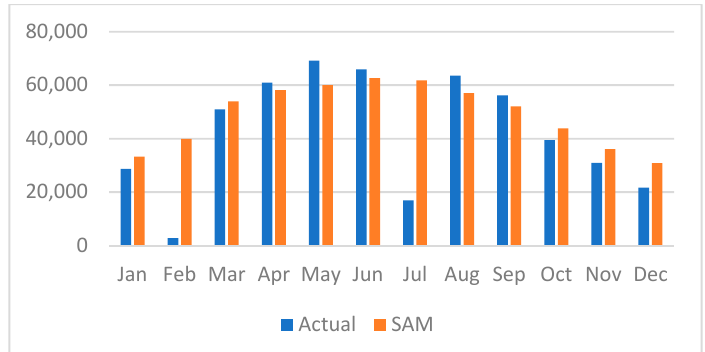
Figure 7. Power production (kW): actual measured onsite by NREL, and simulated by SAM.